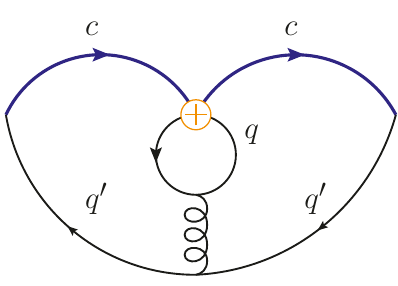
Figure 6 . Diagram describing the eye-contractions.